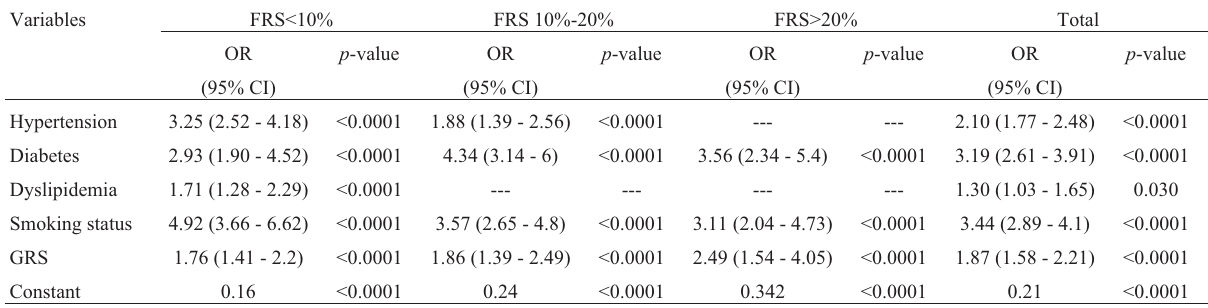
Table 2 - Logistic Regression*model for CAD in subgroups of Framingham 10-year risk (< 10; 10-20%;>20%) and in total population .